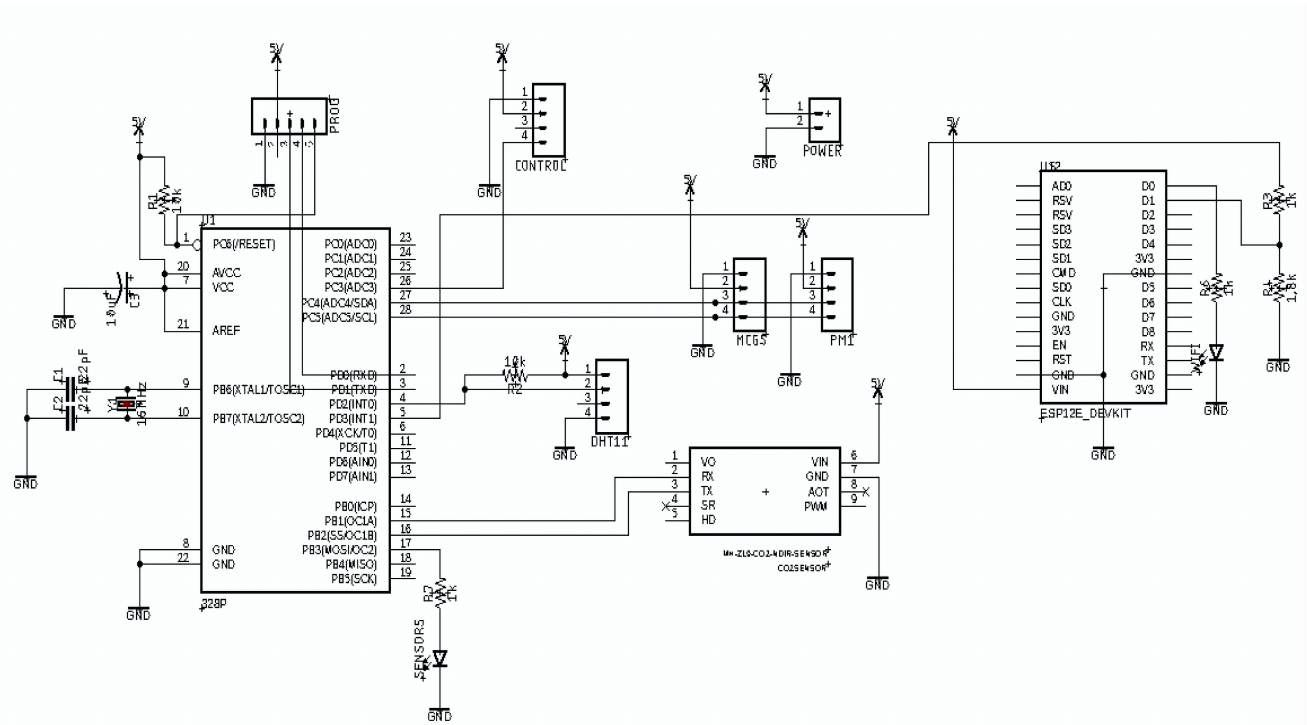
Figure A1. PCB Schematics of Indoor air quality monitoring